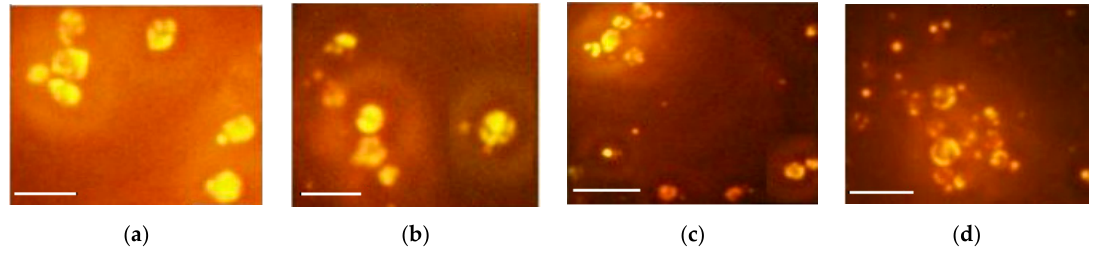
Figure 2. Microscopic examination of yeast cells stained with Nile red fluorescence dye. Yeast cells were grown in a shaken flask under different C/S ratios and a C/N equal to 146, using ammonium sulfate and yeast extract as a nitrogen source for six days. The C/S ratios used were: ( a ) 254, ( b ) 166, ( c ) 123, and ( d ) 98. The magnification bar is equal to 10 µm. Table 4. Effect of different C/S ratios on dry cell weight (DCW), lipid (TL), and carotenoid (TP) produced by R. glutinis after three days and six days.